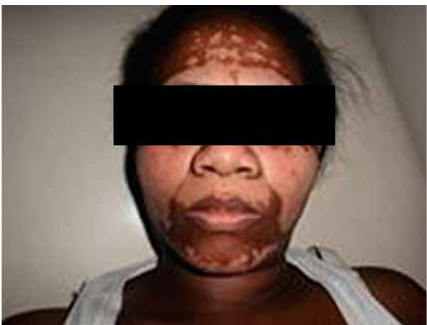
Figure 1: Facial achromic lesions (archive of the Department of Dermatology, Joseph Raseta Befelatanana University Hospital, Antananarivo, Madagascar).